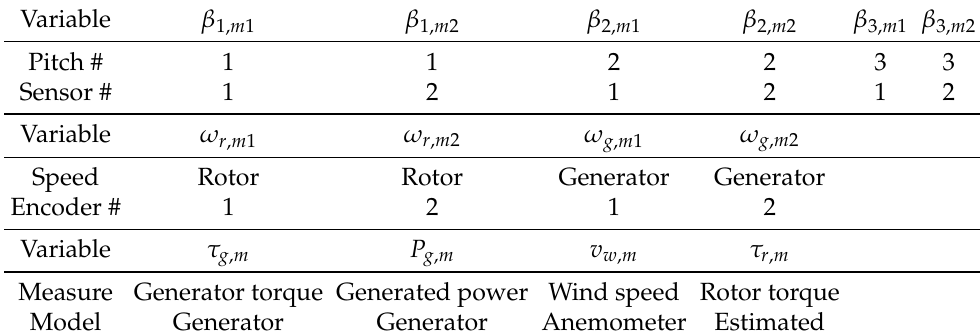
Table 1. Signals acquired from the WT